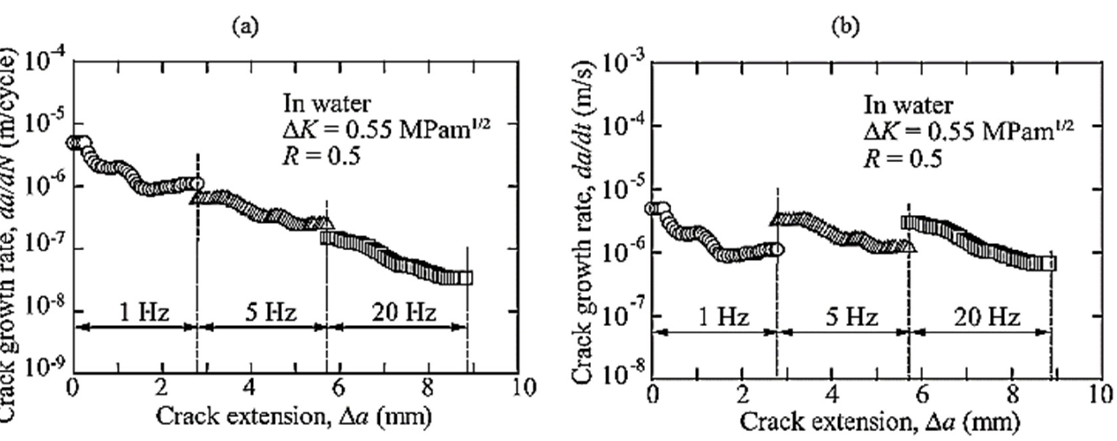
Figure 1. Unidirectional structure.